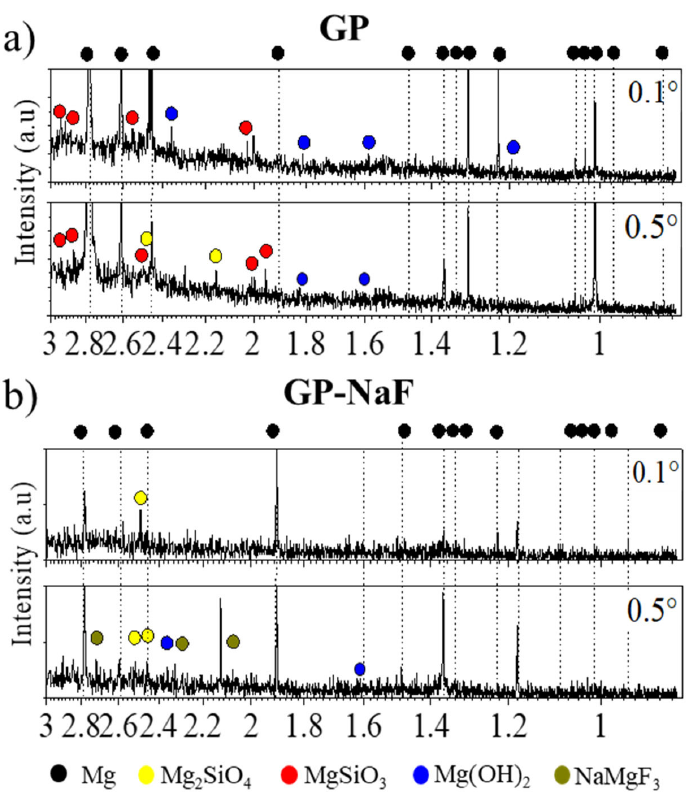
Figure 2. Grazing Incidence hard X-ray Diffraction (GI-XRD) patterns obtained at different incidences angles α i = 0.1 and 0.5 ◦ of ( a ) GP and ( b ) GP-NaF.